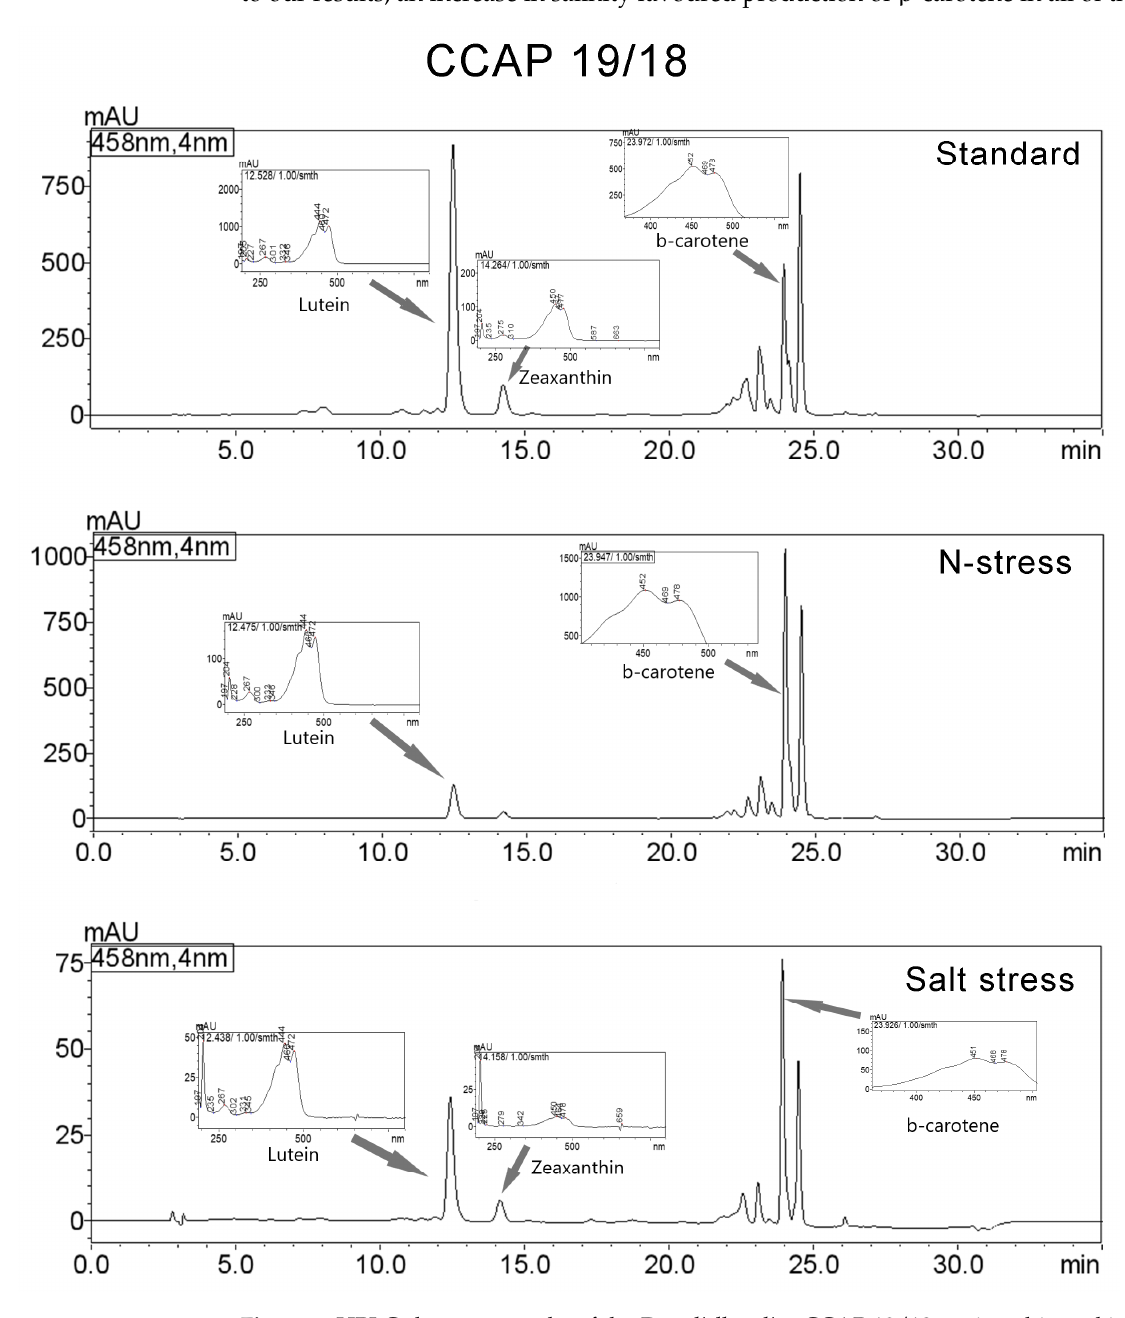
Figure 7. HPLC chromatographs of the Dunaliella salina CCAP 19/18 strain cultivated in standard conditions, under nitrogen deprivation (N-stress) and under high salinity (salt stress). Lutein, zeaxanthin and β -carotene peaks are marked on the chromatographs.